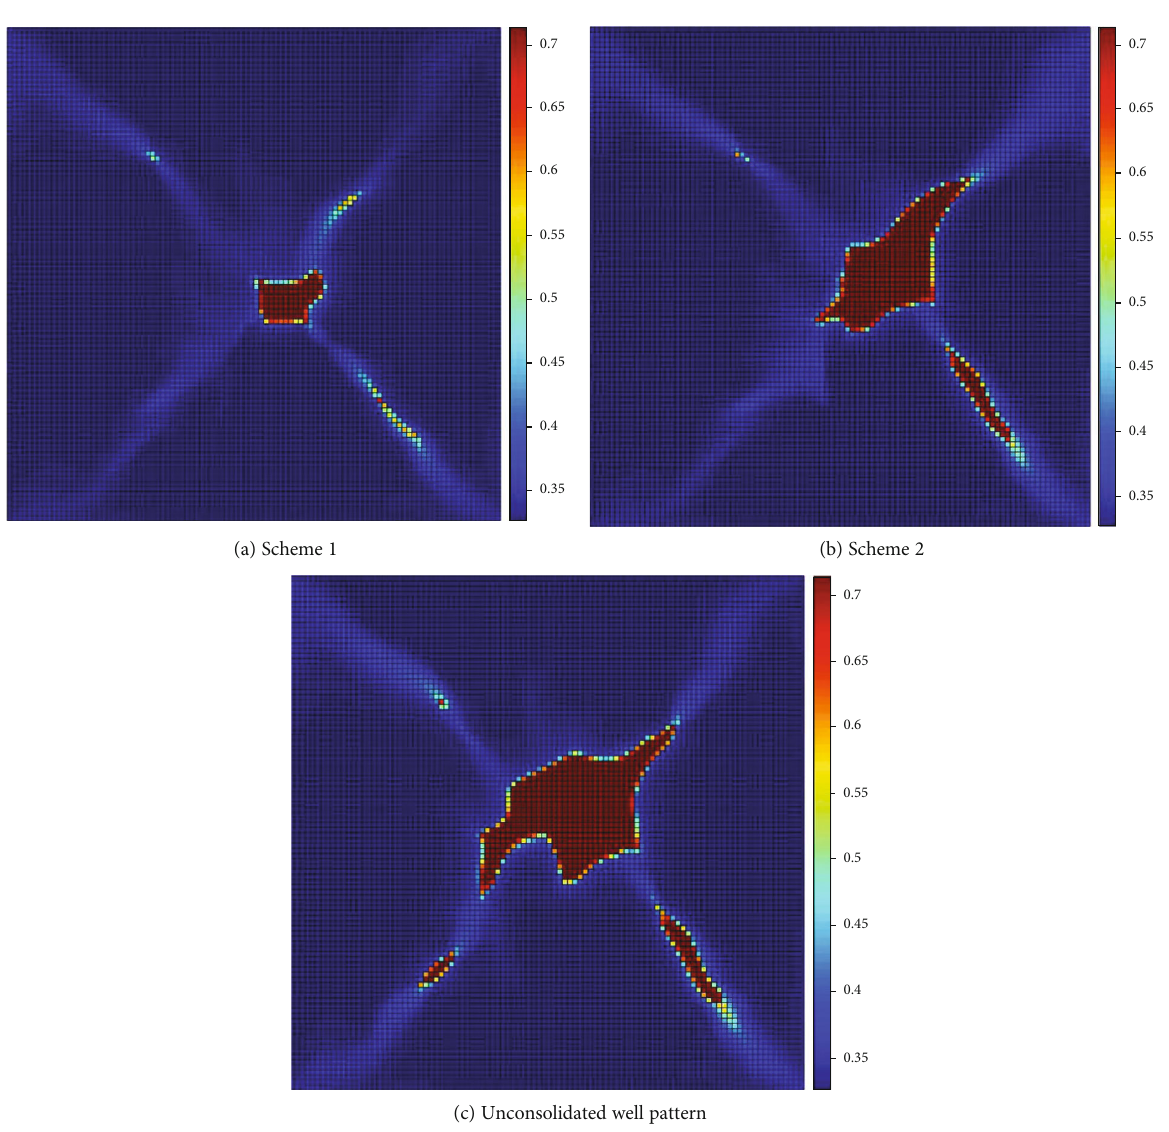
Figure 12: The remaining oil distribution after 20 years under di ff erent